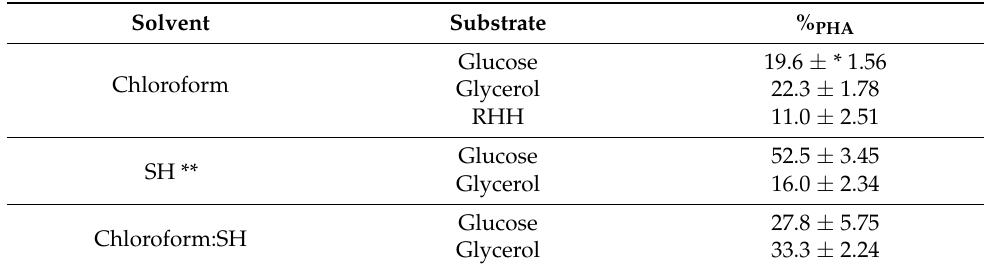
Table 2. Percentage of PHA obtained through the three strategies used in the extraction methodology. Solvent Substrate